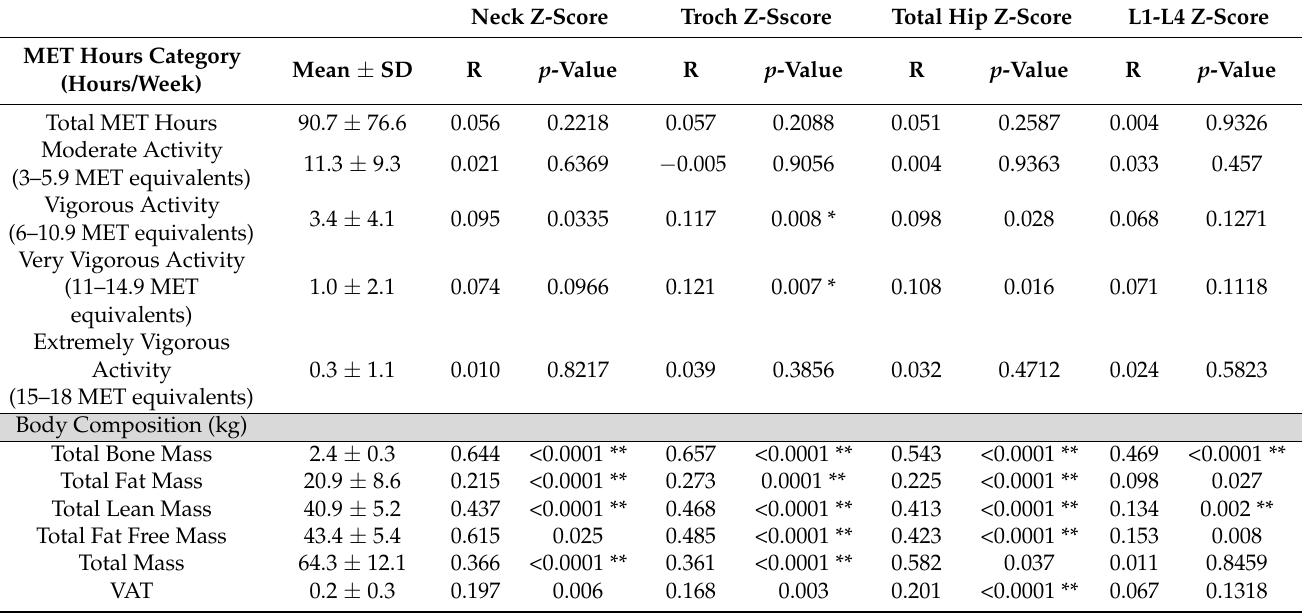
Table 4. Correlations between self-reported number of MET hours per week during 18-month period of interest and BMD Z-score at each site N = 509. Correlations between body composition (in kg) and BMD Z-score at each site. (N =